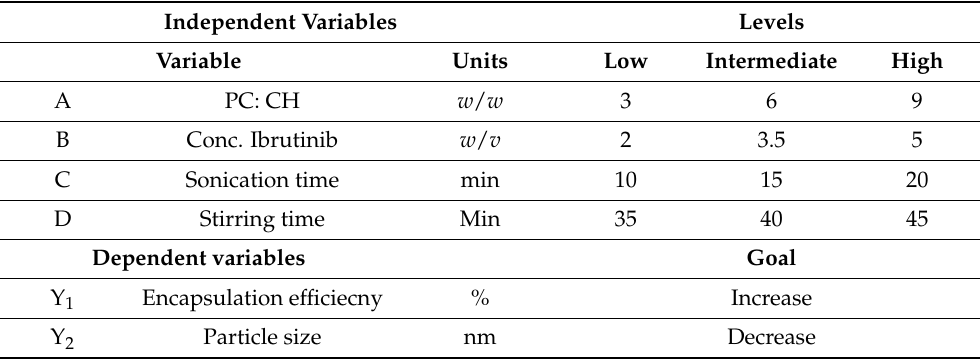
Table 1. BBD with list of dependent and independent